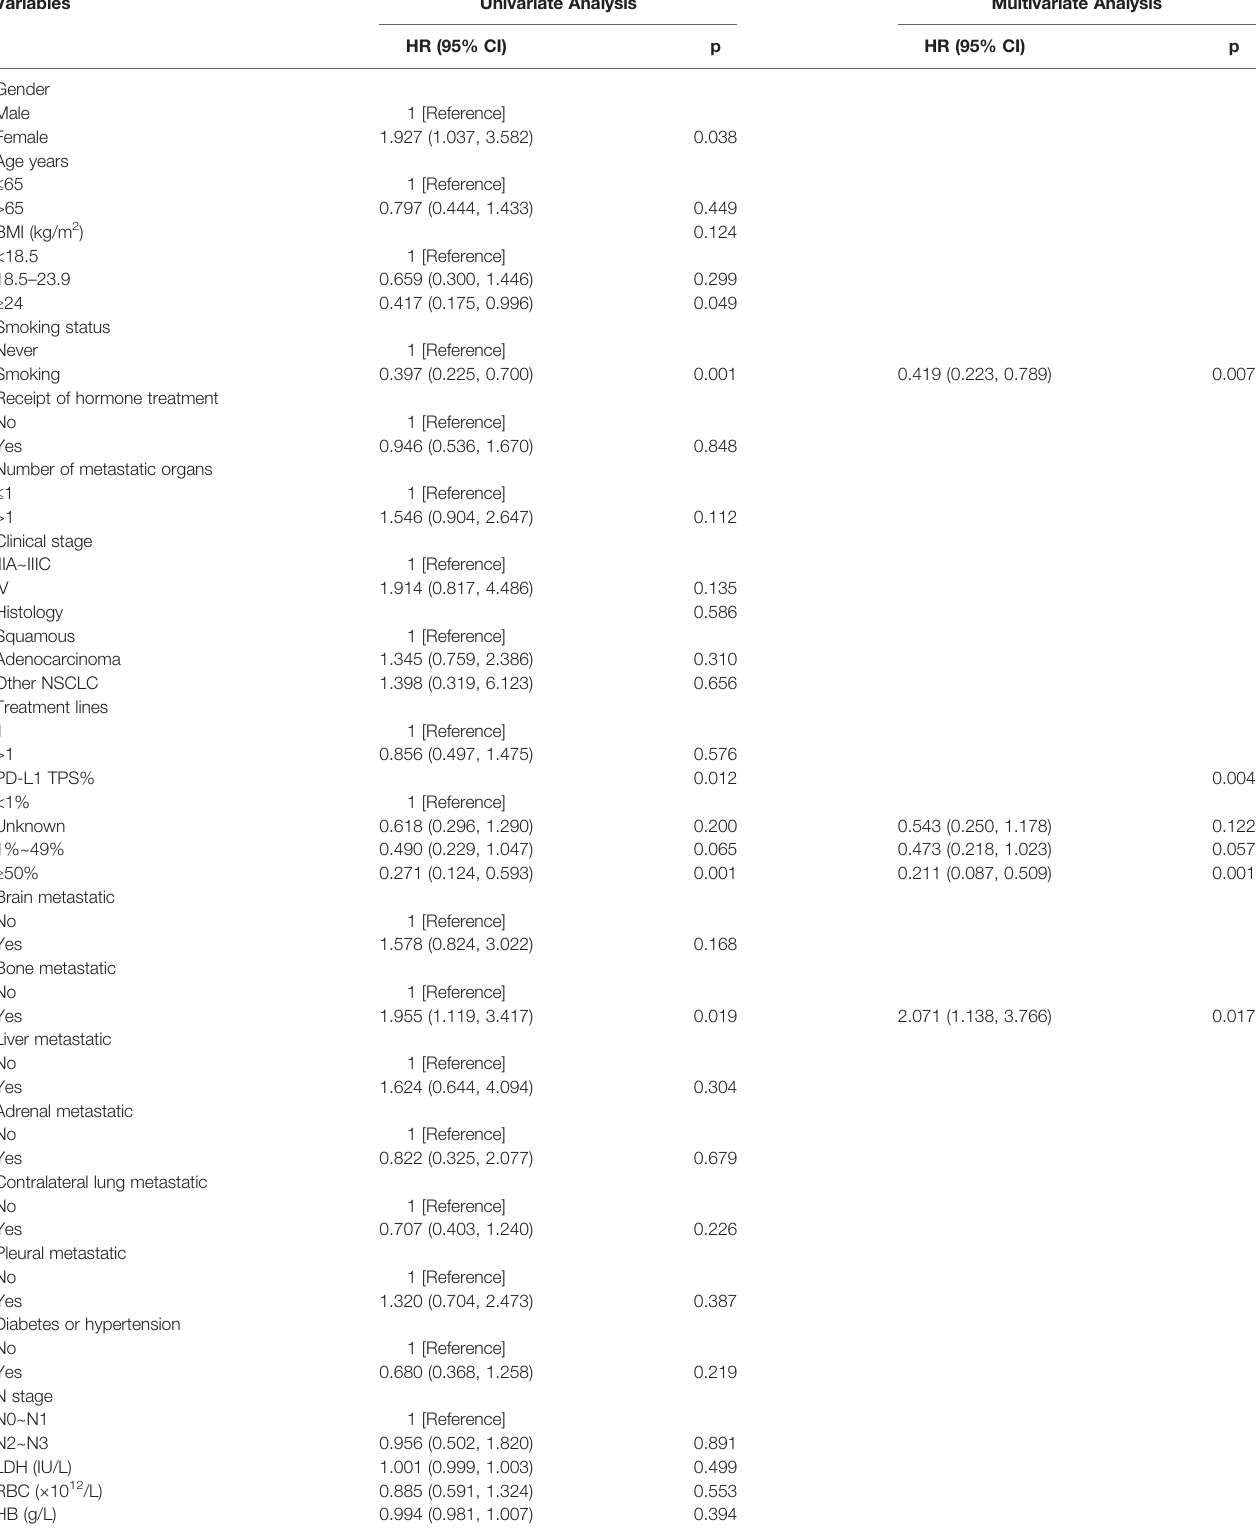
TABLE 2 | Univariate and multivariate Cox analyses of progression-free survival